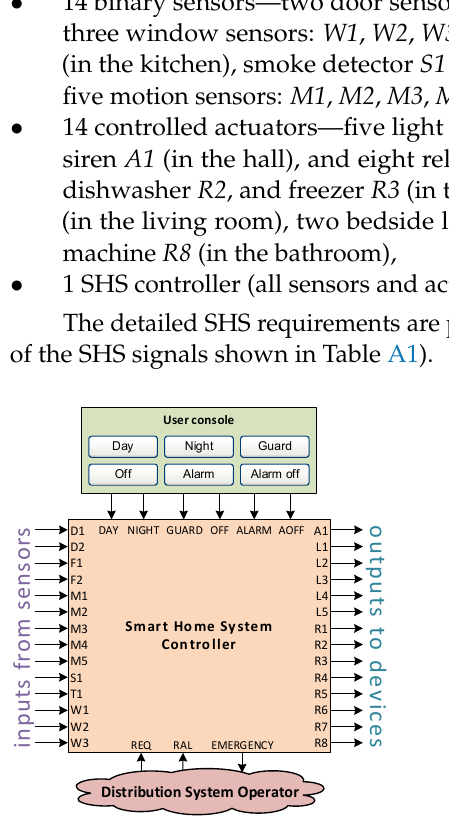
Figure 10. SHS—a block diagram of the SHS controller.